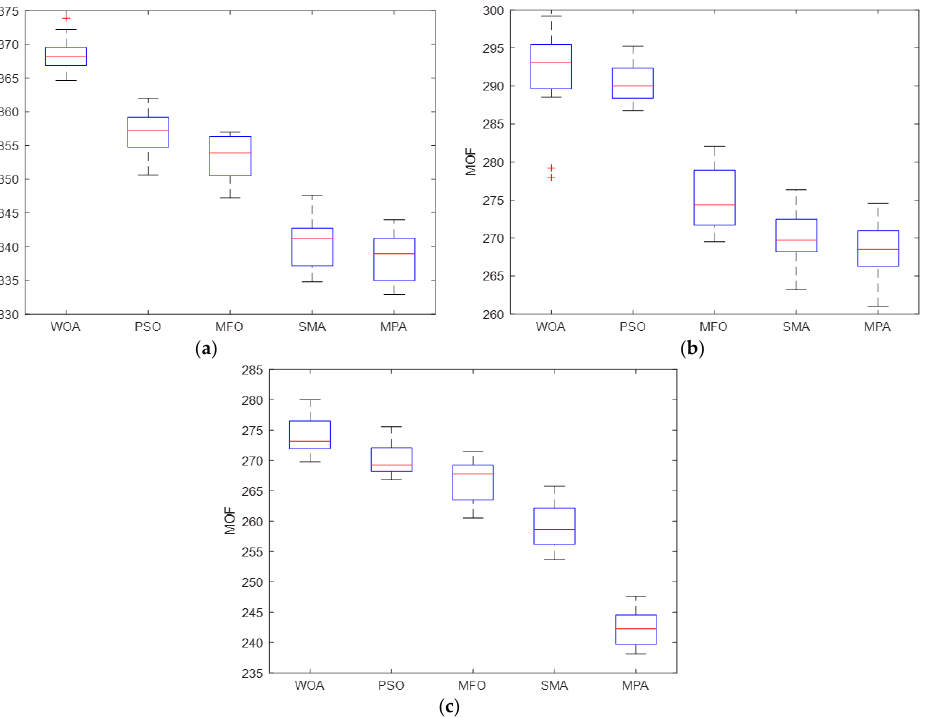
Figure 7. The MOF boxplot after applying the algorithms for the IEEE 69-bus: ( a ) PVDG case; ( b ) WTDG case; ( c ) Hybrid PVDG-WTDG case. Figures 8 and 9 depict the convergence curves for the minimization of MOF when applying the algorithms for the optimal setting of all the studied cases in the two test system EDNs.